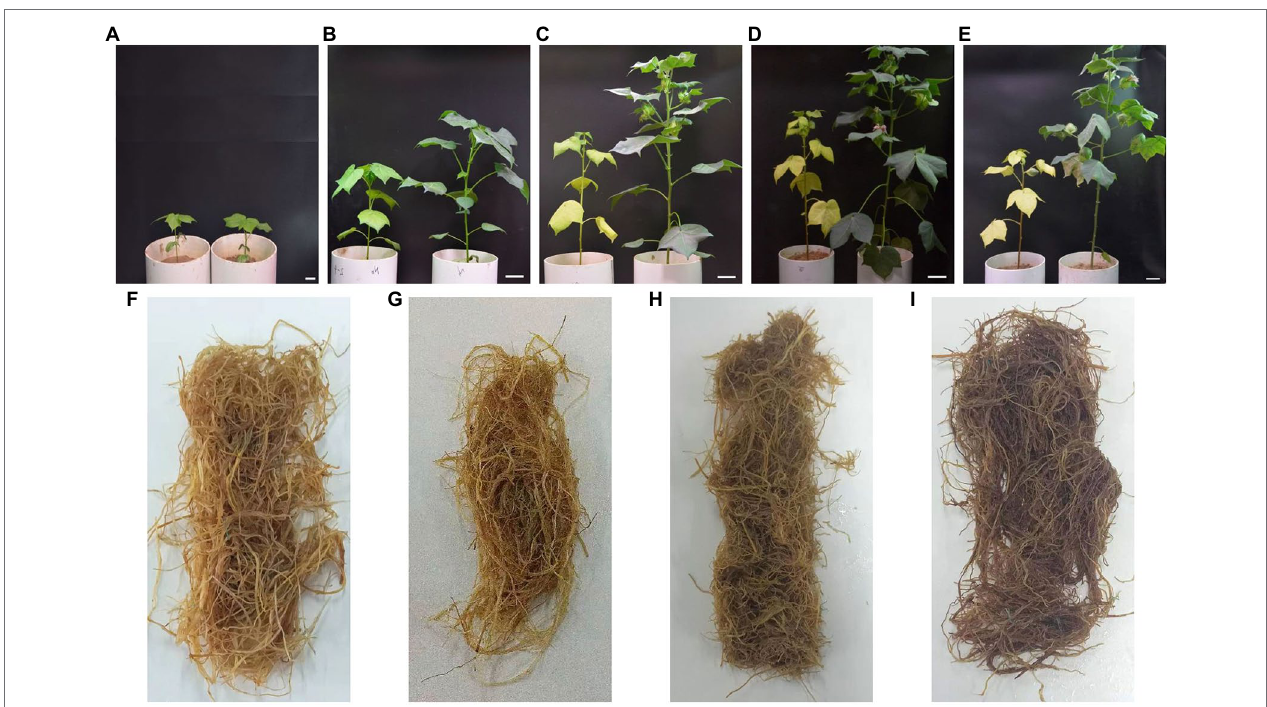
FIGURE 1 | Photographs of dynamic changes in cotton plants and roots under different nitrogen (N) treatments. (A–E) represent the cotton plant at 20, 40, 60, 80, and 100 days after emergence (DAE), respectively. (F,G) Represent the cotton root at 80 and 100 DAE under low N treatment; (H,I) represent the cotton root at 80 and 100 days after emergence under normal nitrogen treatment. For each picture of (A-E) , the left side is the low nitrogen treatment, and the right side is normal nitrogen treatment. Scale bar (A-E) = 2